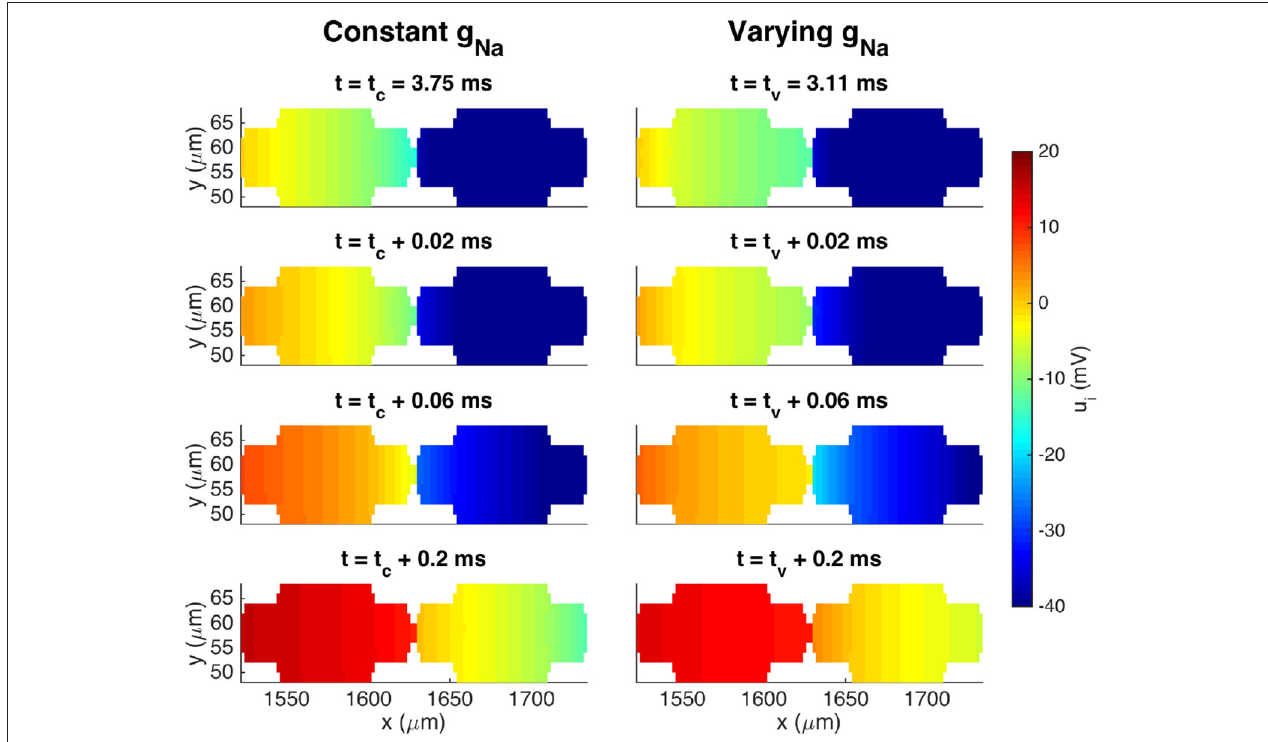
FIGURE 8 | Intracellular potentials at four points in time for the two cells at the center of the domain from the simulation in Figure 7 . The plots in the upper panel show the solutions at the last point in time before the intracellular potential at the start of the first cell is first positive. Because the conduction velocity is different in the two cases, this occurs at two different points in time, t c and t v , for the cases with a constant g Na and a varying g Na , respectively. The next plots show the solutions at times 0.02, 0.06, and 0.2 ms after t c and t v .